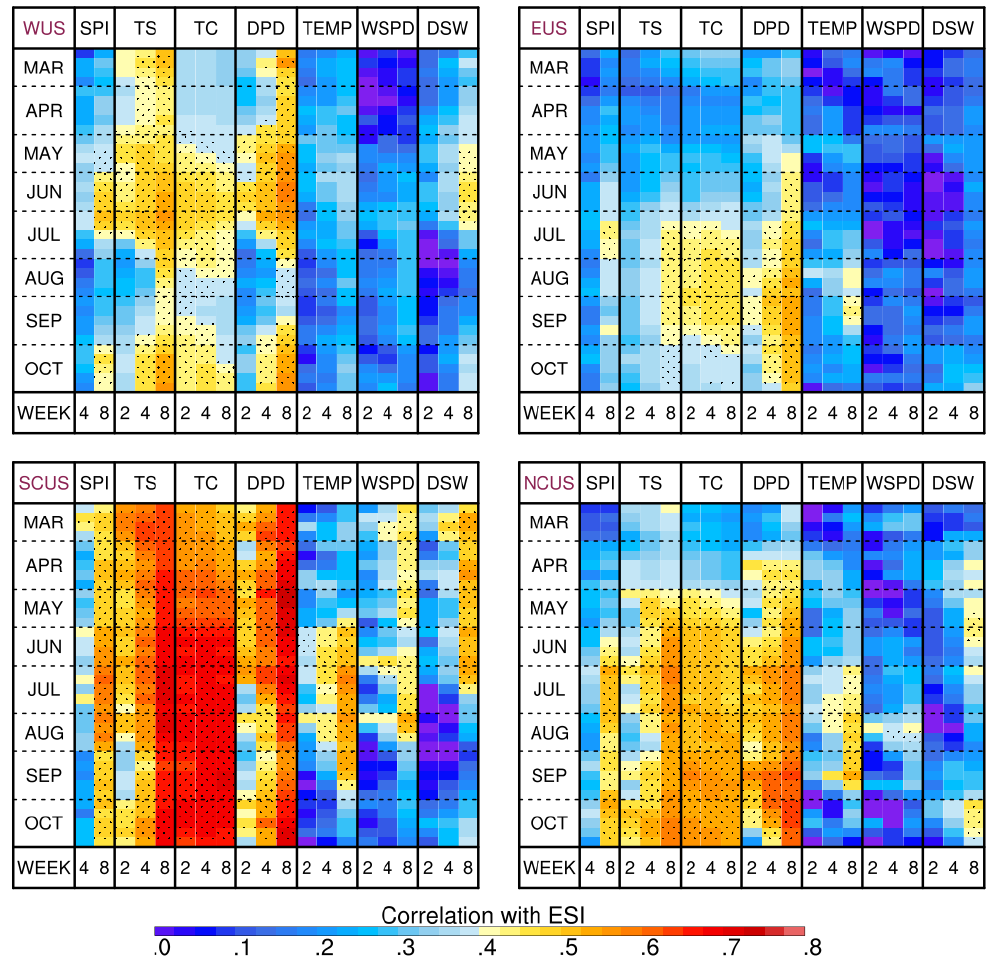
Figure 6. Same as Fig. 4, except for showing correlations computed with respect to 8-week ESI